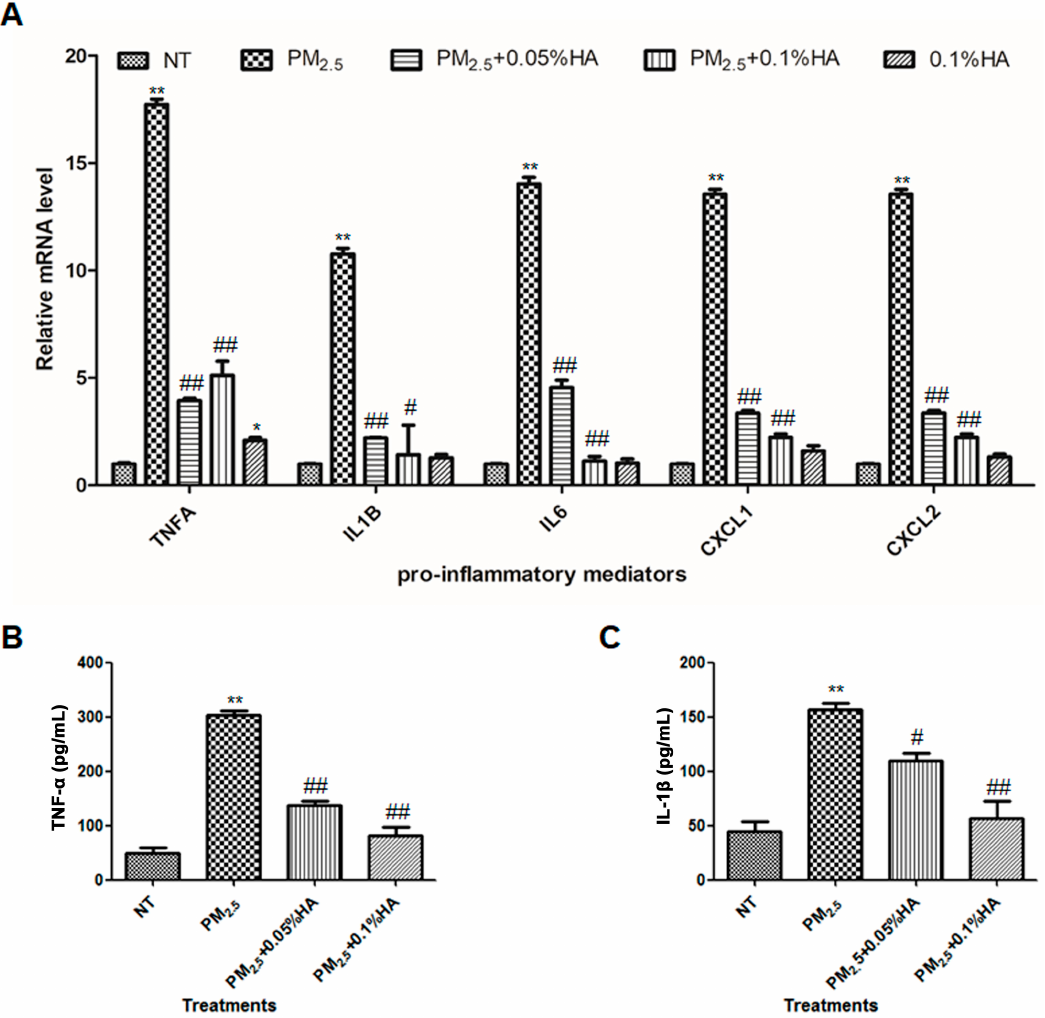
Figure 2. Anti-inflammatory effects of HMW-HA on PM 2.5 -treated macrophages. ( A ) NR8383 cells were exposed to PBS, PM 2.5 , 0.1% HMW-HA, PM 2.5 and 0.05% HMW-HA, or PM 2.5 and 0.1% HMW-HA simultaneously for 6 h, and the mRNA expression of TNFA, IL1B, IL6, CXCL1, and CXCL2 was determined by real-time RT-PCR. ( B , C ) The secretion of TNF- α and IL-1 β by NR8383 cells 24 h after indicated treatments was assessed by ELISA. Data are presented as mean ± SD, and represent three independent experiments. * p < 0.05 and ** p < 0.01, compared with the no treatment (NT) group. # p < 0.05 and ## p < 0.01, compared with cells exposed to PM 2.5